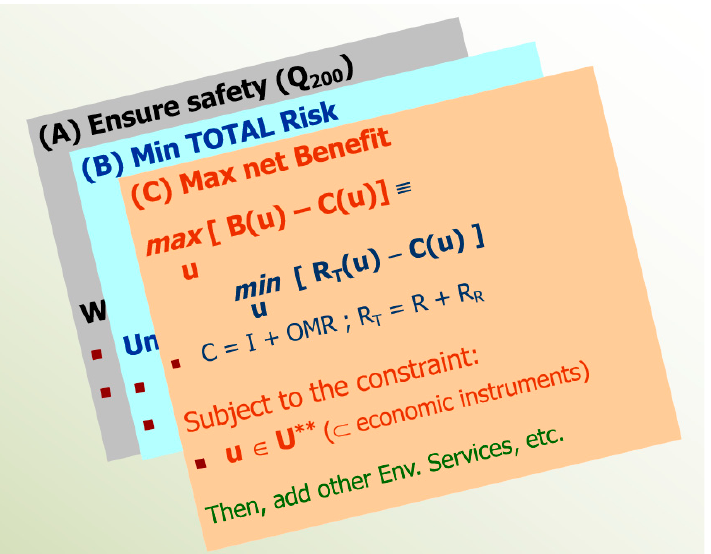
Figure 5. Costs count too: a basic CBA paradigm (B stands for Benefits and C for Costs) including the total risk R T and the total cost C (investment I plus OMR), all depending on planning decision u belonging to a wider set U **. The terms are differential with respect to a reference alternative, e.g., present situation where I is null.